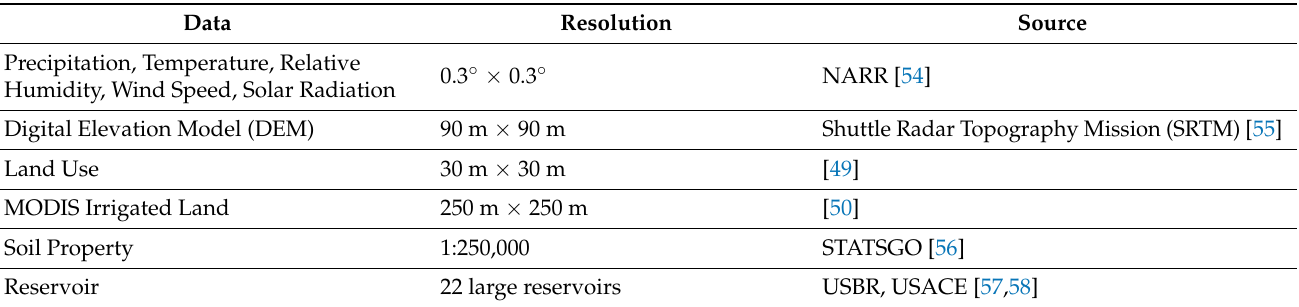
Table 1. SWAT model input